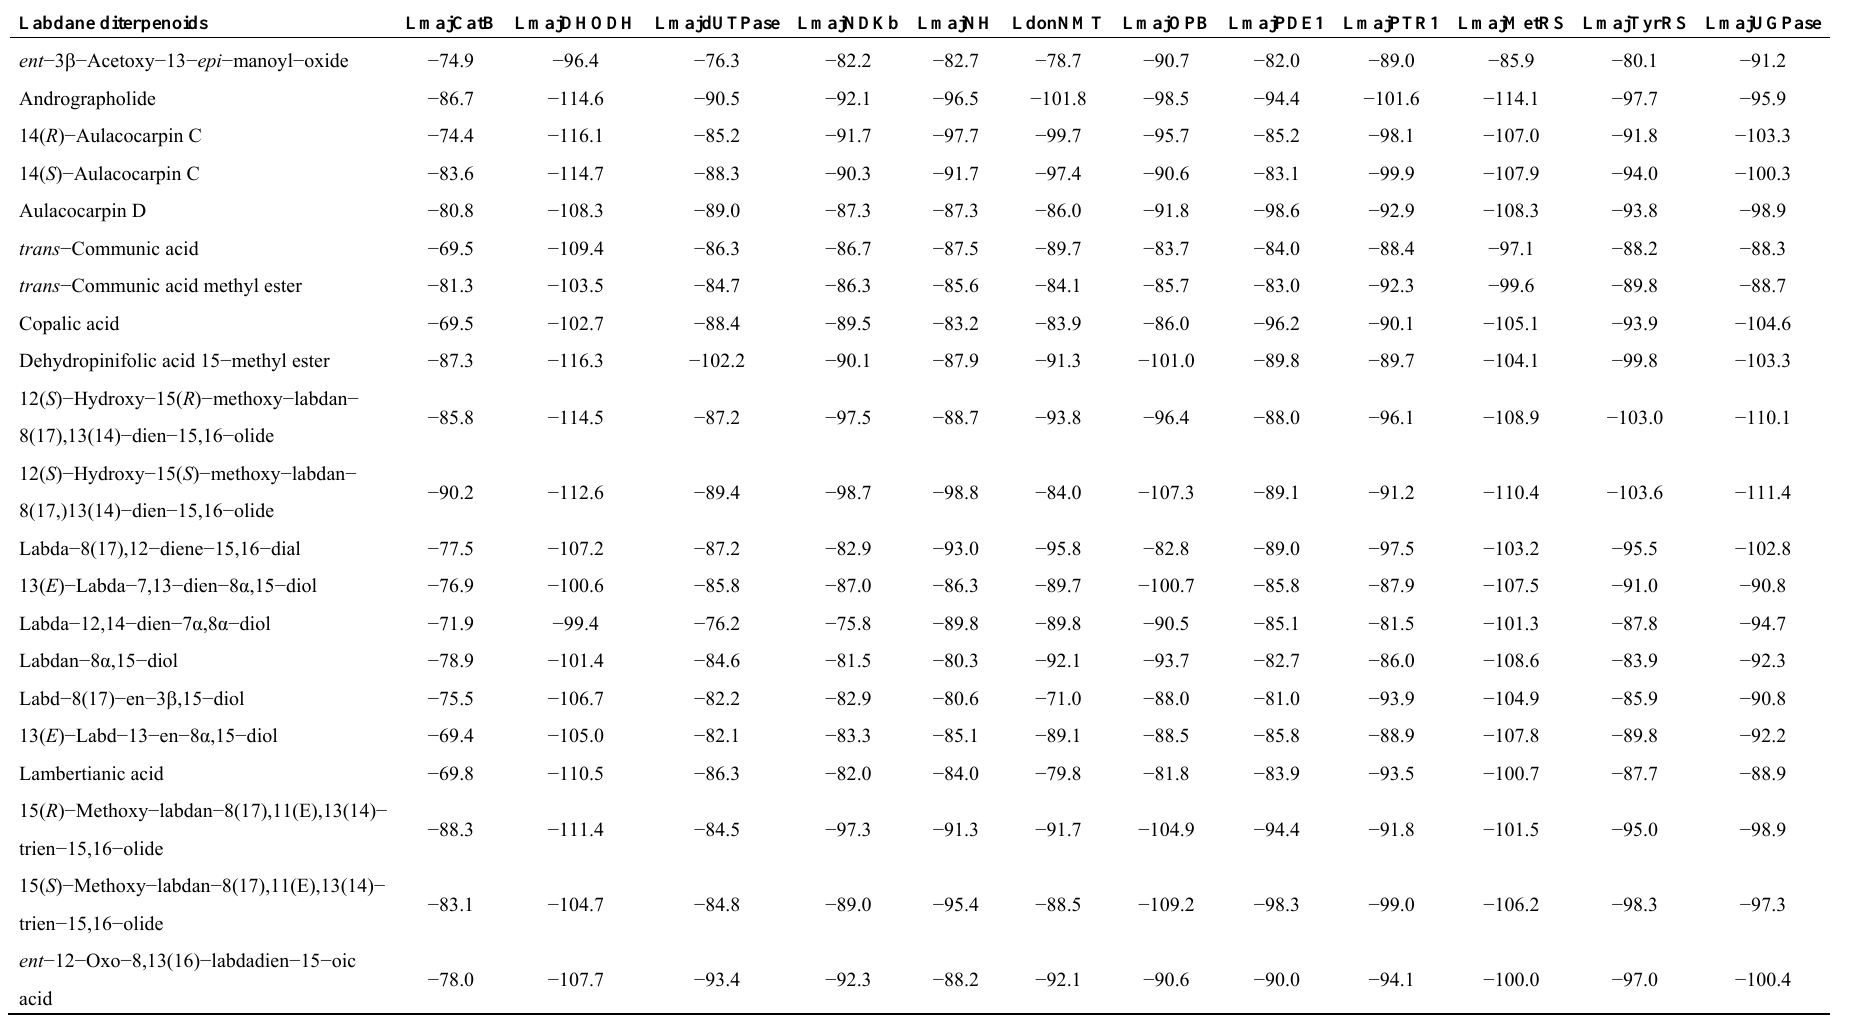
Table 22. MolDock docking energies (kJ/mol) of labdane diterpenoids with Leishmania major protein